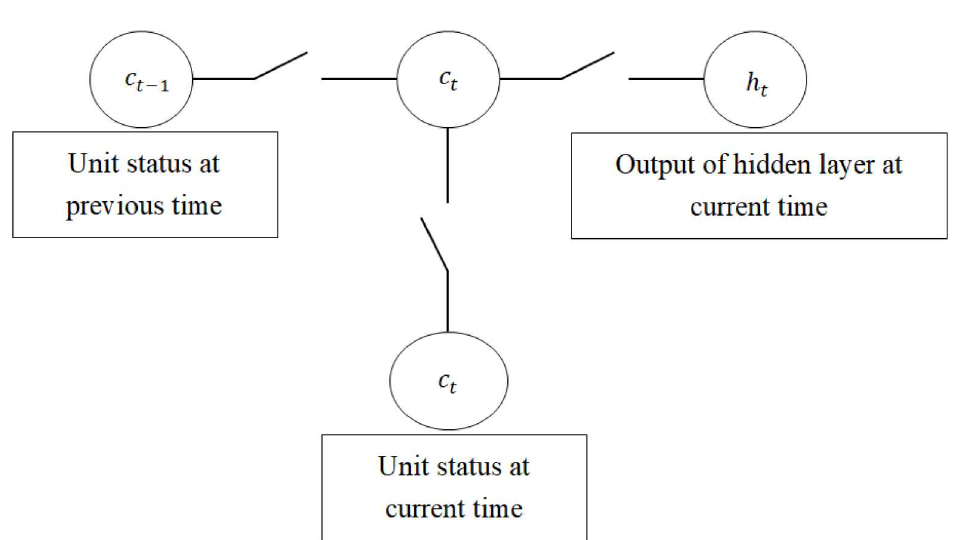
Fig. 3 LSTM model.